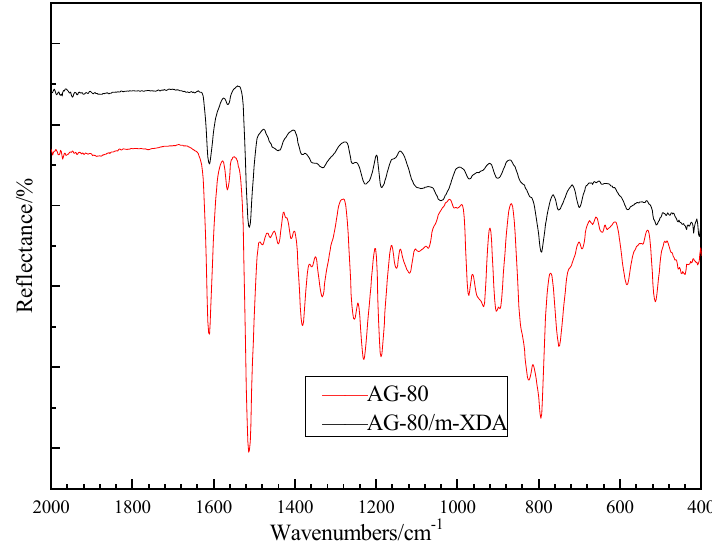
Figure 6. The FTIR curves of AG-80 epoxy resin and AG-80 / m-XDA cured system ( phr = 26).